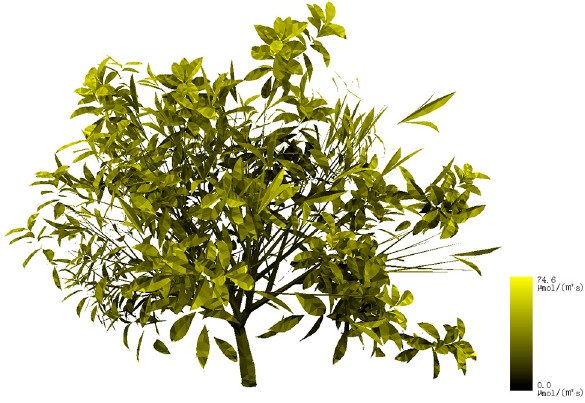
Figure 8. A screenshot of the diffuse PAR distribution within the virtual loquat canopy at 12:00 on June 21, 2016. The brightness corresponds to the irradiation intensity.